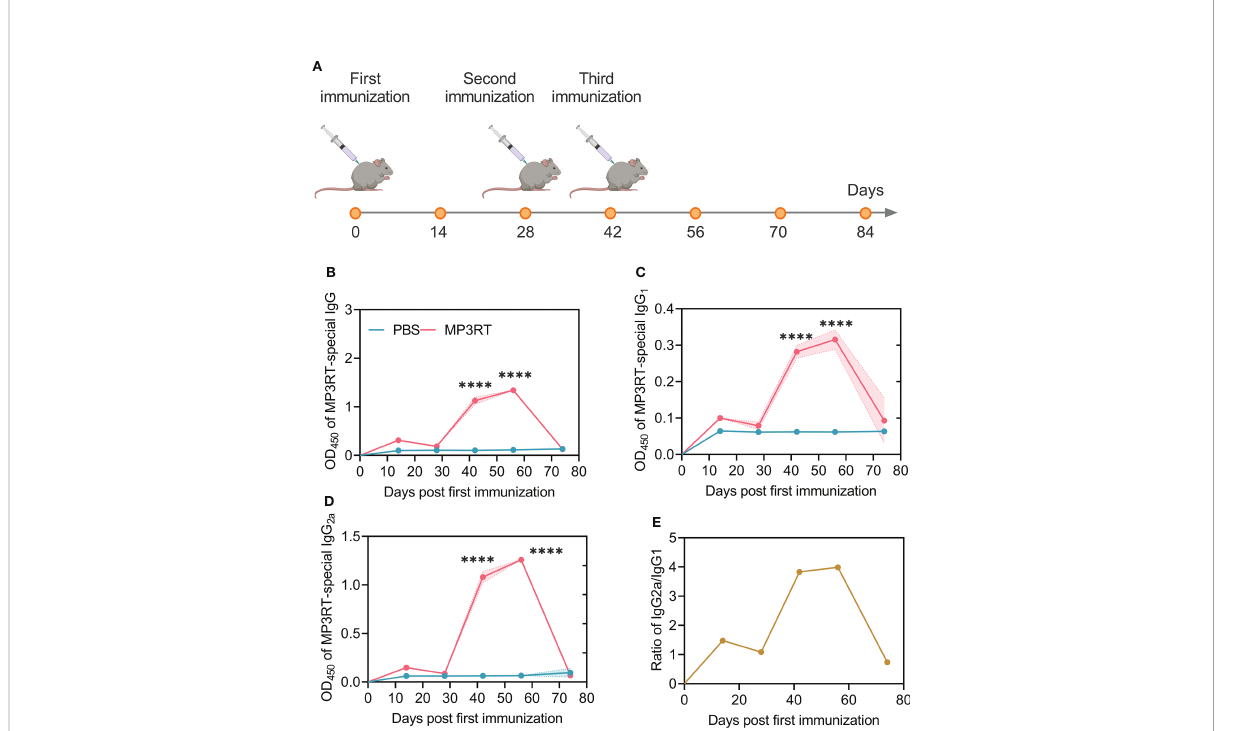
FIGURE 8 Schematic diagram of mouse immunization and detection of MP3RT-speci fi c antibodies in mice. (A) Time of injection of the MP3RT vaccine and PBS in humanized mice. (B – E) The levels of the MP3RT-speci fi c IgG, IgG 1 , IgG 2a antibodies, and IgG 2a /IgG 1 ratio in mice vaccinated with MP3RT and PBS. Six serum samples in PBS group or 7 serum samples in MP3RT group were pooled together and tested in quadruplicate for antibody detection. The results were analyzed with the Unpaired t-test or Mann-Whitney test according to the normality. All data were shown as mean + SEM ( n = 4). P < 0.05 was considered signi fi cantly different. ****, P <